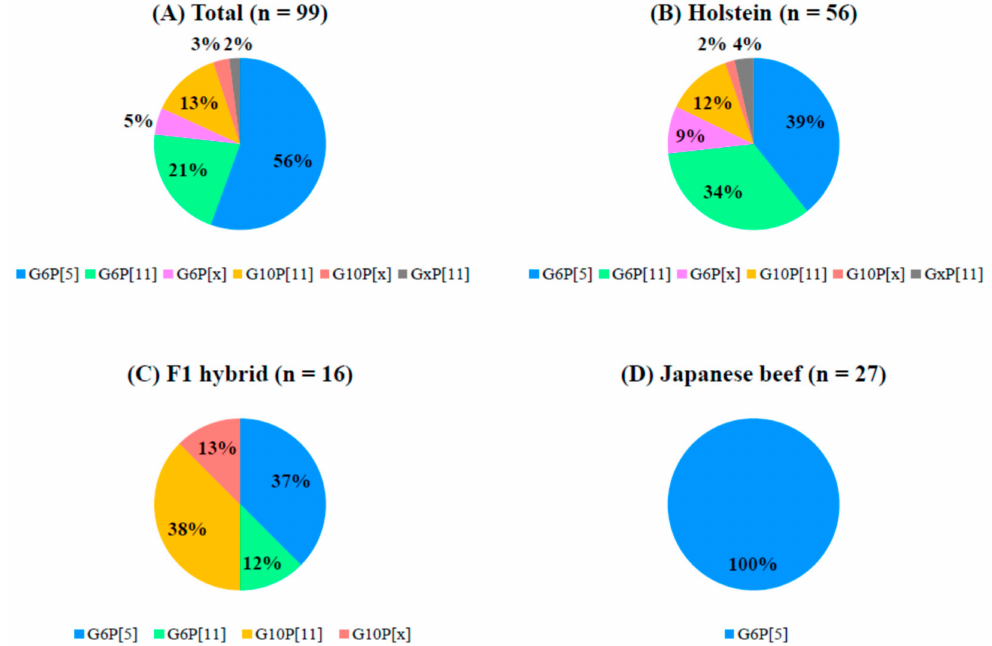
Figure 3. Frequency (in percent) of the occurrence of G and P genotypes of bovine rotaviruses A in each cattle type. ( A ) Total, ( B ) Holstein calves, ( C ) F1 hybrids, and ( D ) Japanese beef calves. Di ff erent combinations of G and P genotypes are shown in di ff erent